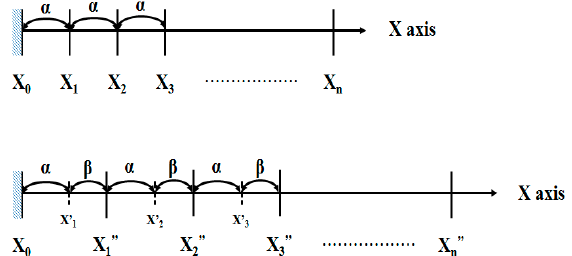
Figure 3. The displacement variation of the solid material by a uniaxial load.